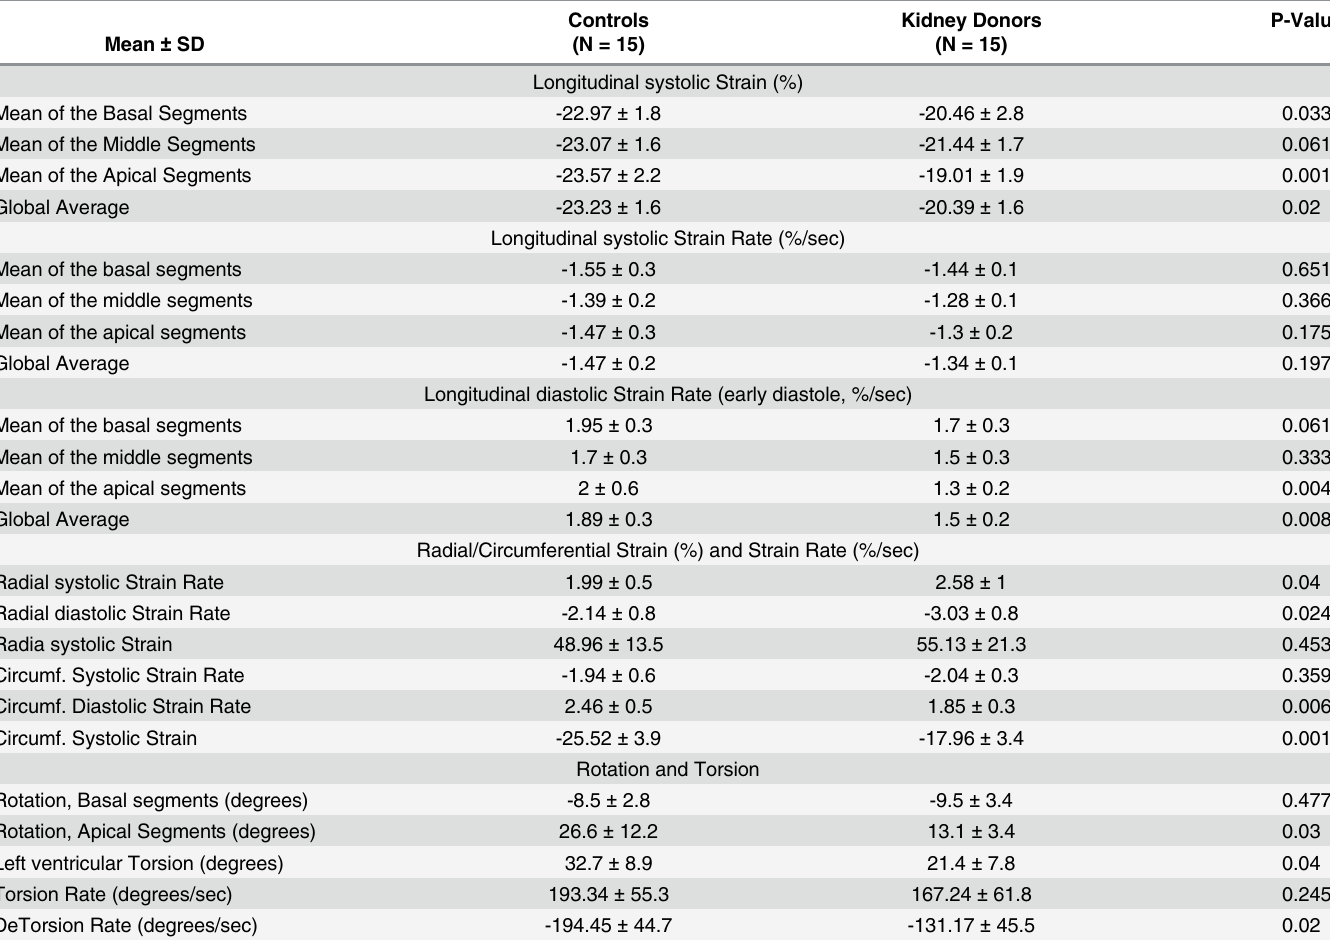
Table 3. Cardiac Mechanics and Rotation/Torsion, by ECHO Strain. Speckle myocardial Imaging data over longitudinal, radial and circumferential LV axes in kidney donors and controls. Basal/Apical Rotation and Torsion of the LV in the 2 groups are reported as